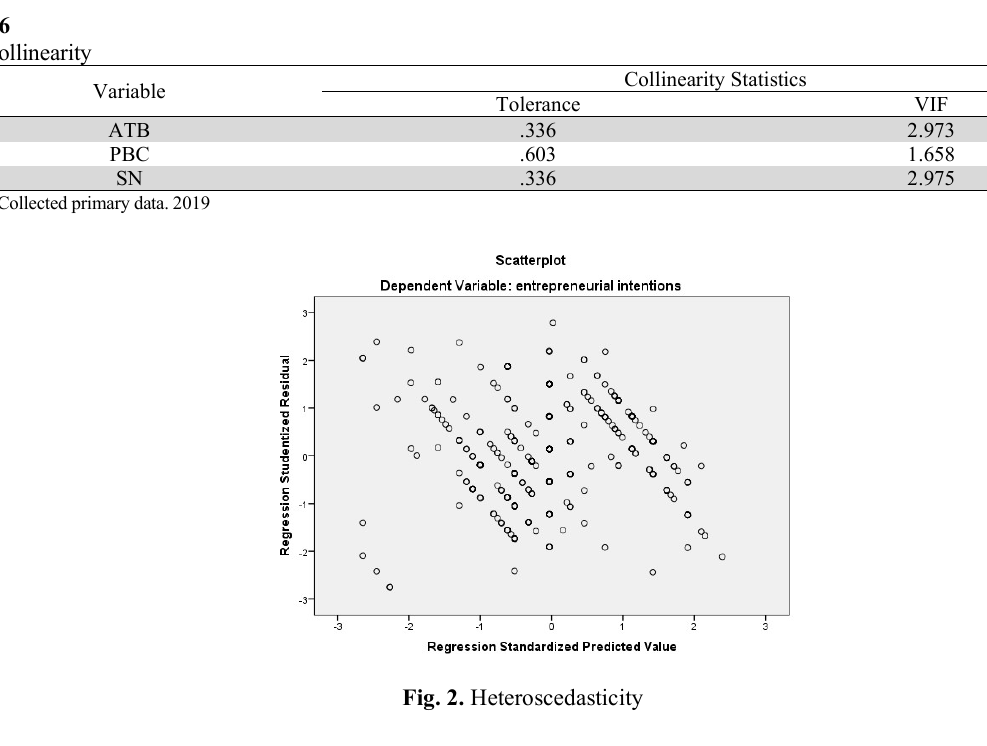
Collinearity Statistics